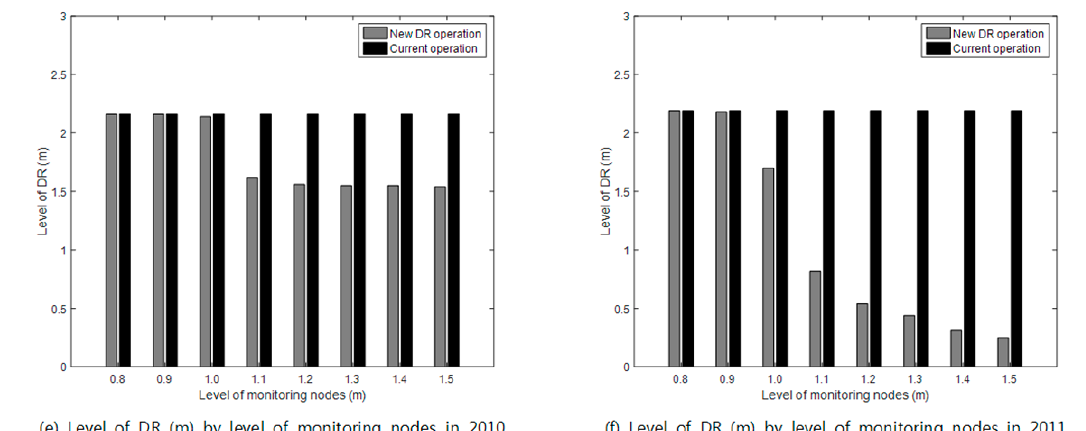
Figure 13. Results of the new decentralized reservoir operation.